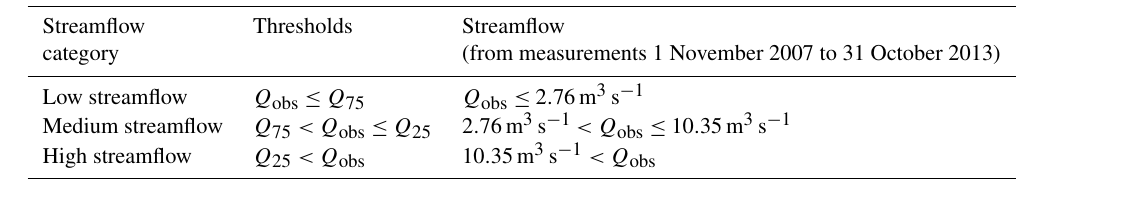
Table 2. Characterization of the high-streamflow-generating processes.